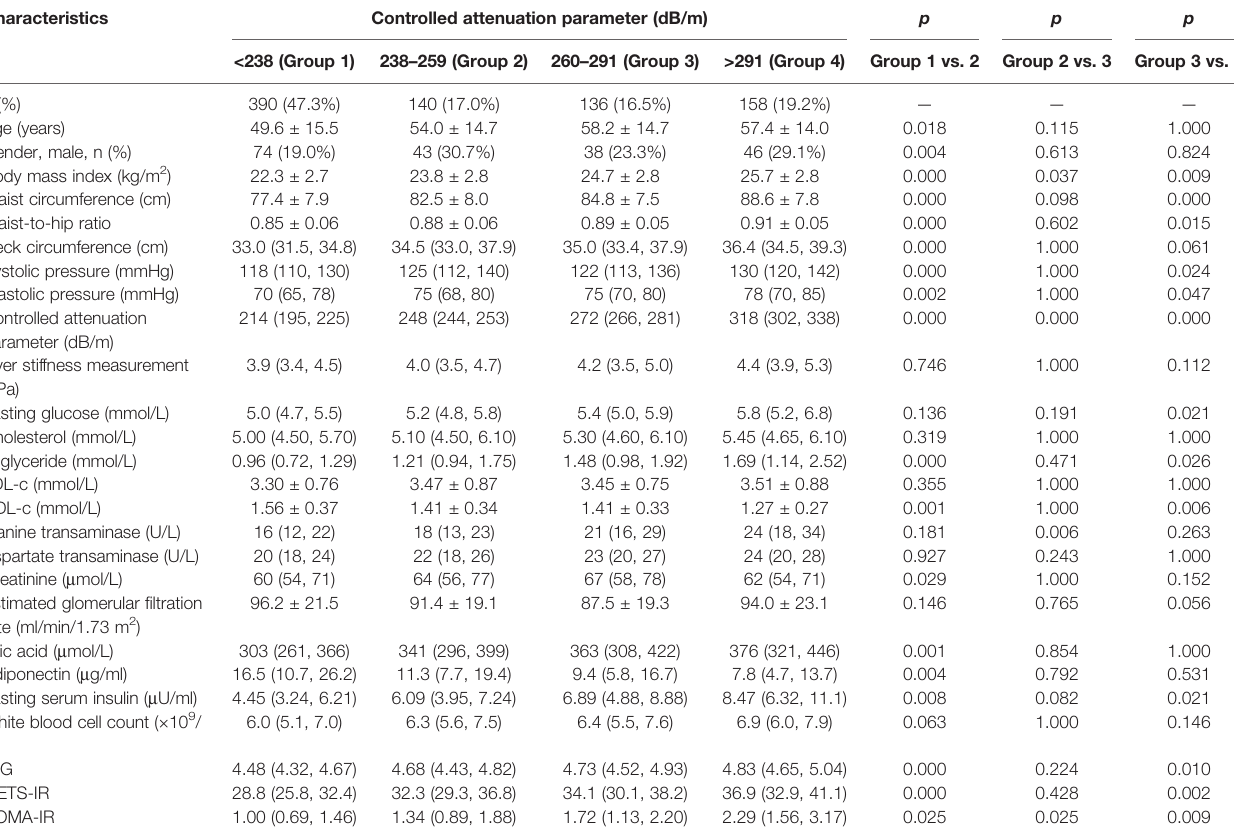
TABLE 2 | Comparison of clinical characteristics among subjects in different CAP categories.